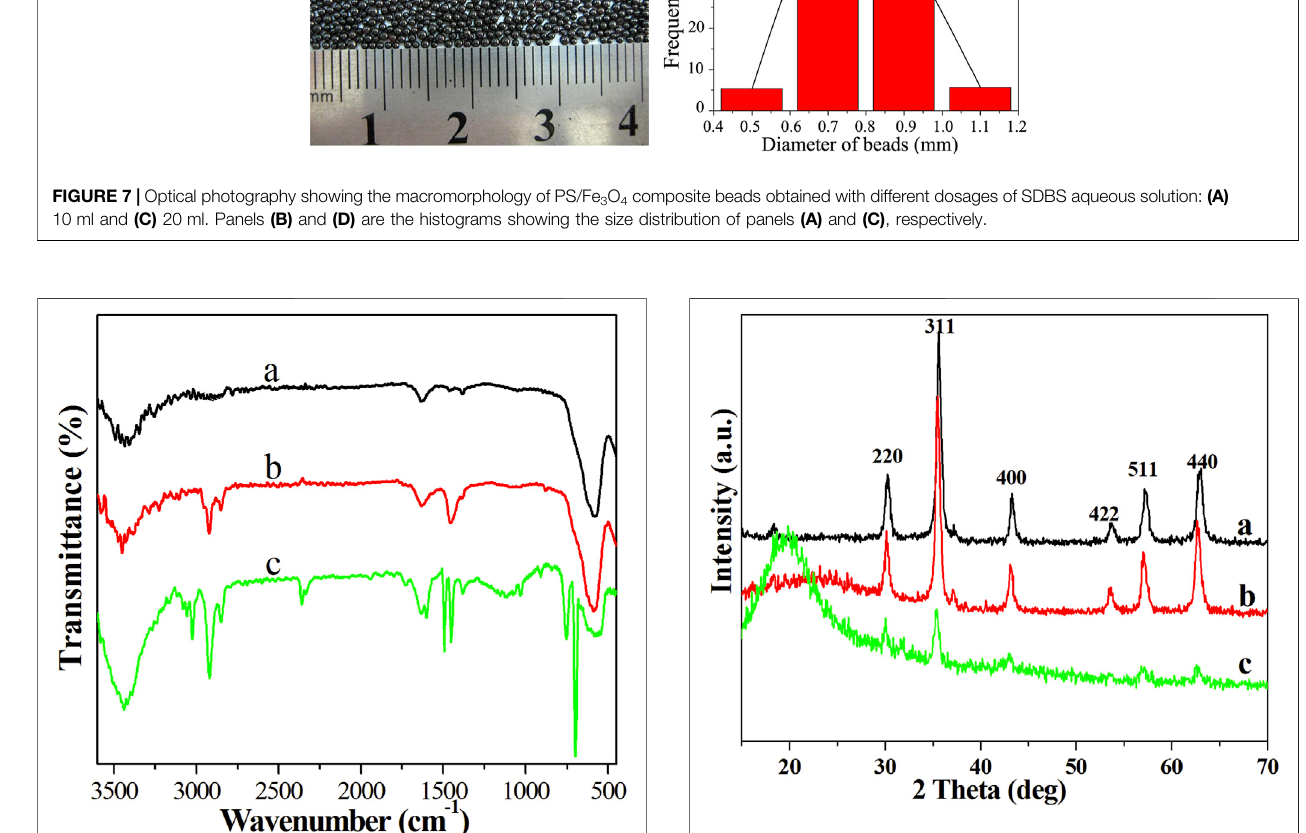
FIGURE 9 | XRD patterns: (A) Fe 3 O 4 , (B) OA-Fe 3 O 4 , and (C) PS/Fe 3 O 4 composite beads. FIGURE 8 | FT-IR spectrum: (A) Fe